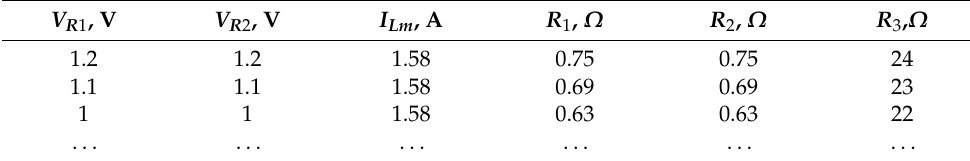
Table 3. Parameters of output stage.